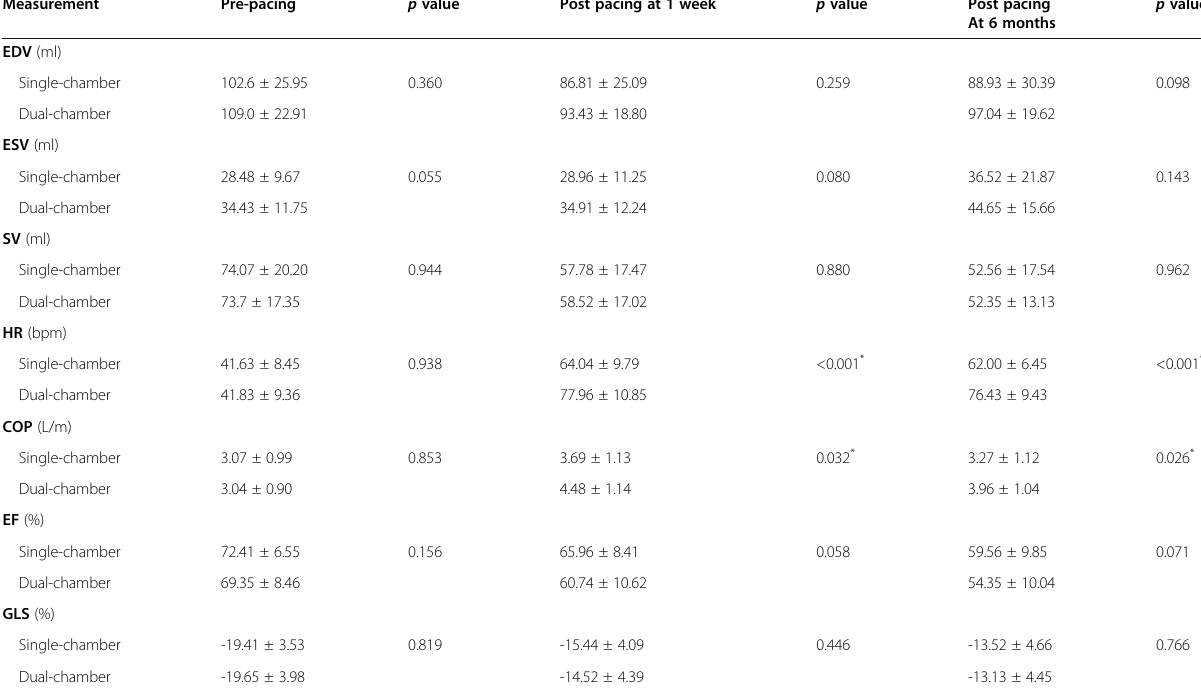
p value At 6 months